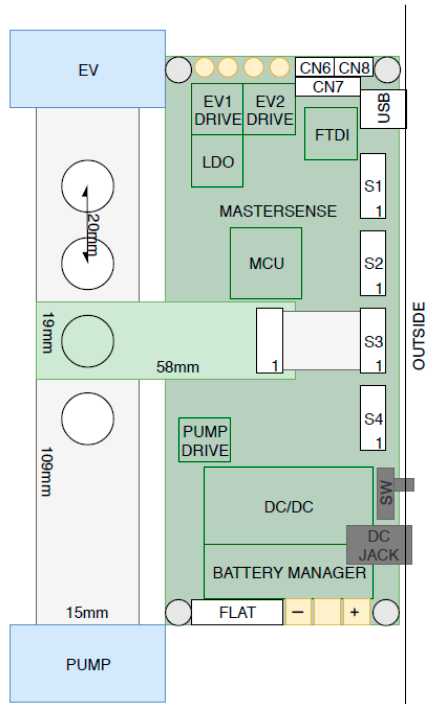
Figure 1. Layout of the measurement chamber: EV = solenoid valve; EV1 drive = control driver for solenoid valve; EV2 drive = driver for additional solenoid valve; CN6-CN7-CN8 = connectors dedicated for settings; FTDI = USB to Serial converter; USB = USB port; S1-S2-S3-S4 = connectors for the four sensor’s board; MCU = microcontroller; PUMP DRIVE = pump controller; DC/DC = DC/DC 12 V out converter for battery charge management; FLAT = Connector used for debugging; PUMP = brushless pump (model KNF NMP 03 KPDCB-1, 3.3 Volt) for continuous 24 h operation; SW = ON/OFF switch; DC JACK = power supply input (DC 15–36 V).